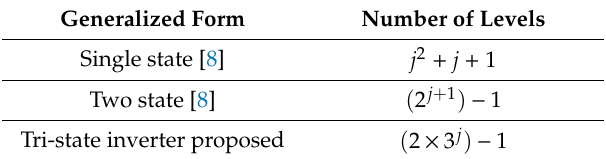
Table 5. Comparison between the number of state architectures and generated output levels.